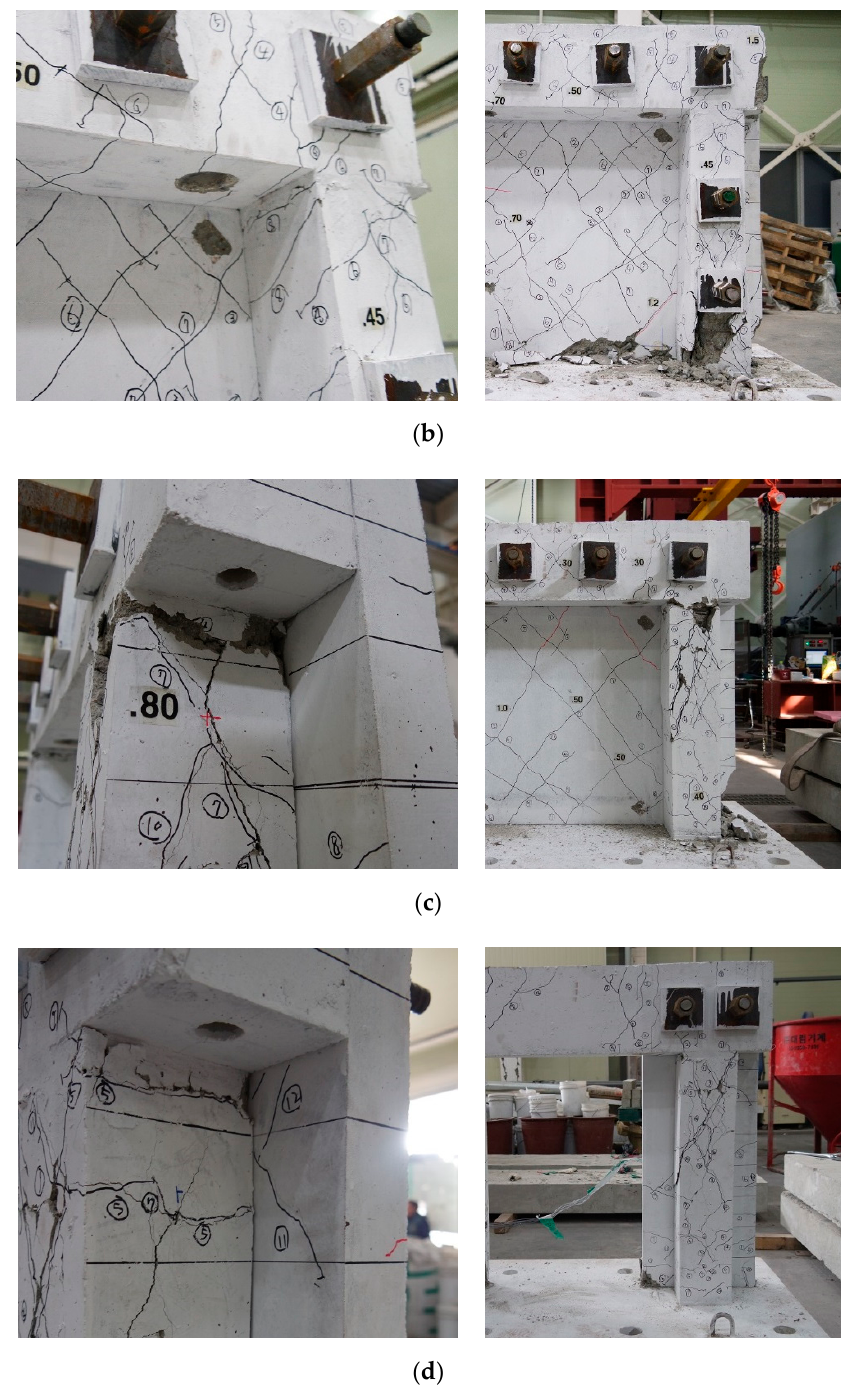
Figure 8. Photographs of specimens after failure: ( a ) Specimen FC; ( b ) Specimen FBC; ( c ) Specimen FB; ( d ) Specimen FPB.